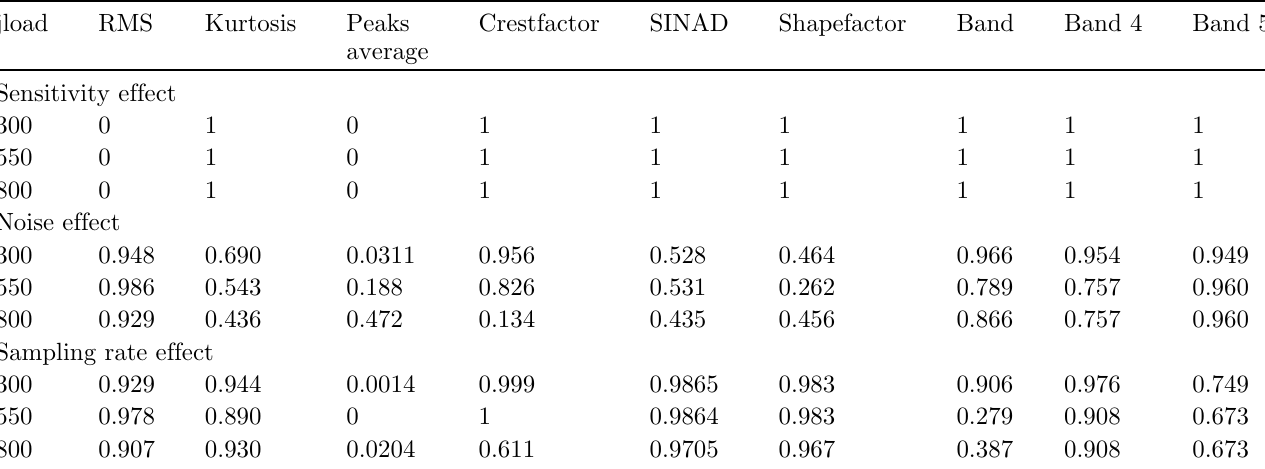
Table 2. ANOVA test for the test case 2: p